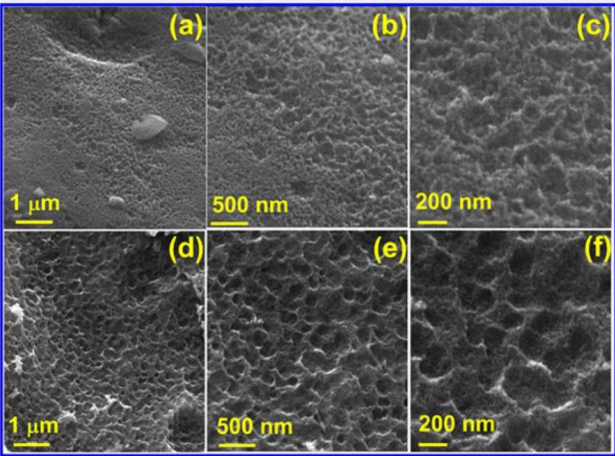
Figure 2. FESEM images of ( a – c ) PC and ( d – f ) N-PC.